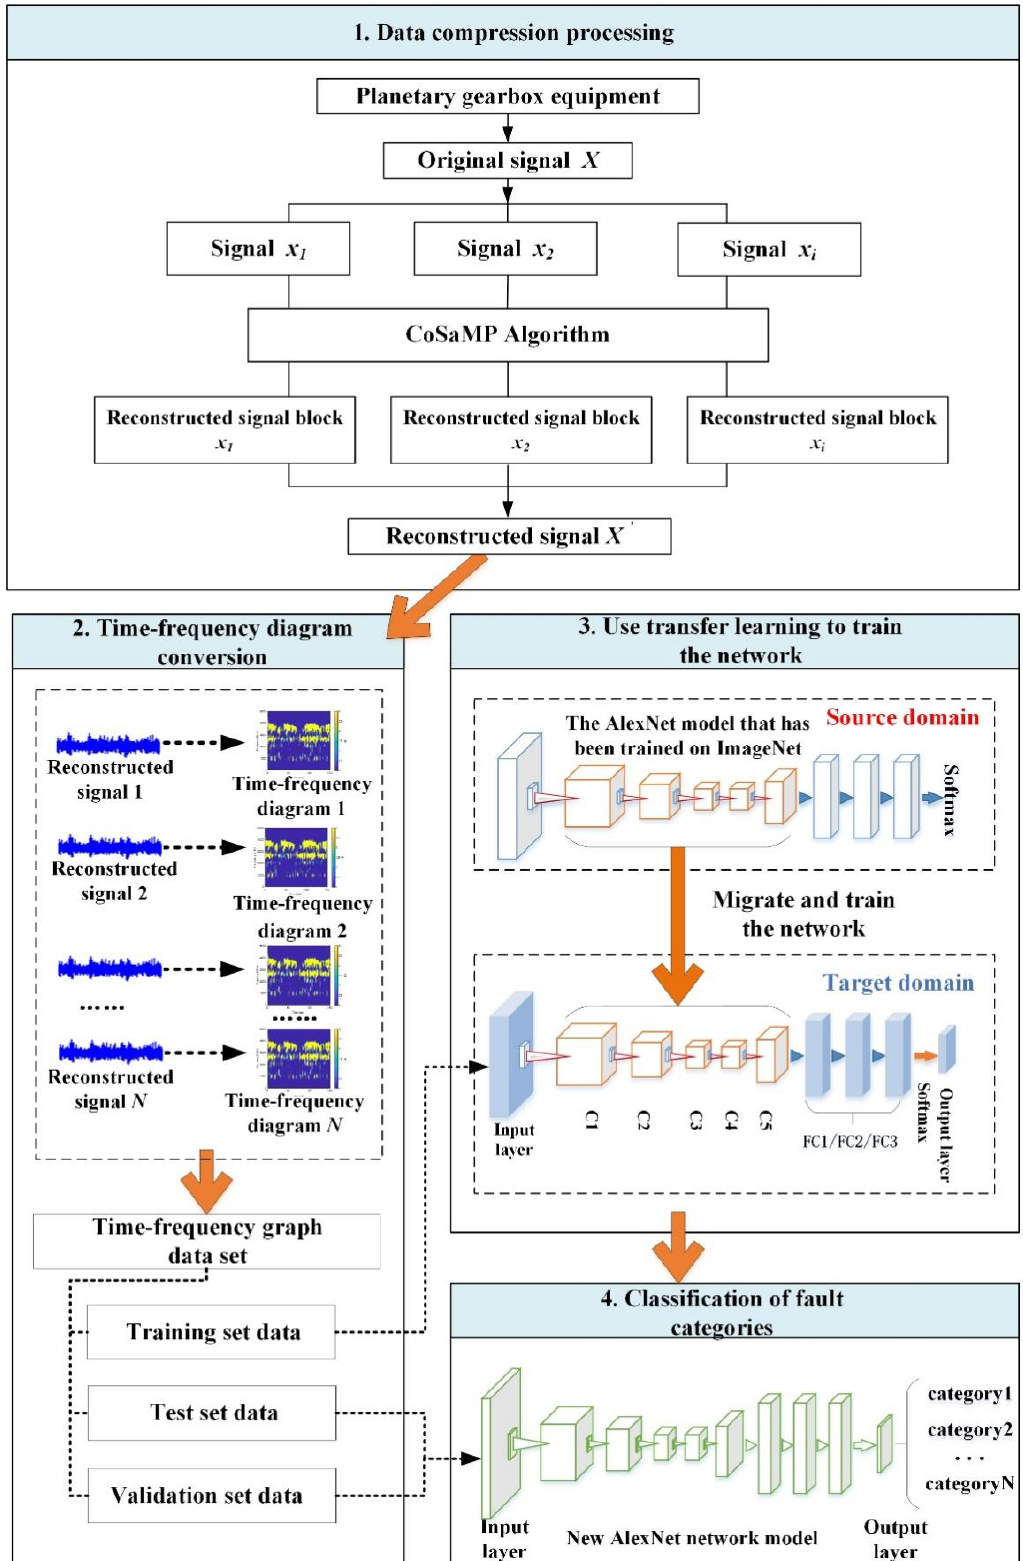
Figure 4. Process of fault diagnosis method based on deep transfer learning and compressed sens- ing.